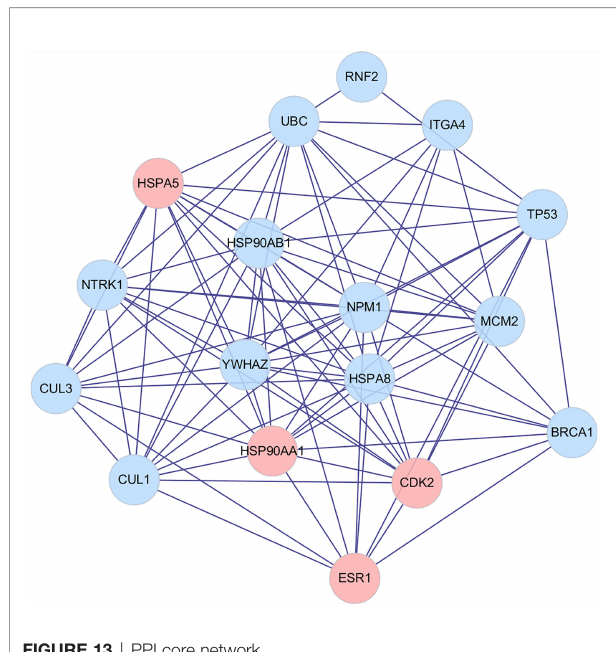
FIGURE 13 | PPI core